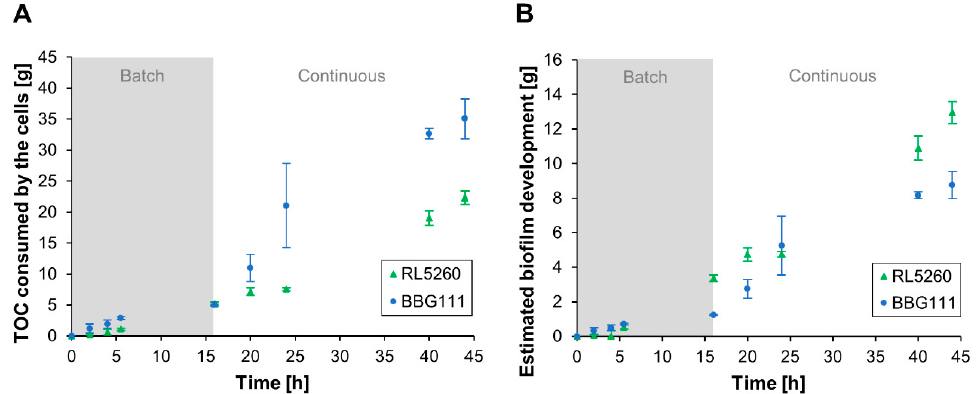
Figure 6. ( A ) Cumulative total organic carbon (TOC) consumption by the cells during the cultivation of the two B. subtilis 168 strains. ( B ) Cumulative biofilm development on the packing elements estimated via the TOC mass balance and obtained biomass-TOC conversion yields. Error bars indicate the standard deviation of the measurements.